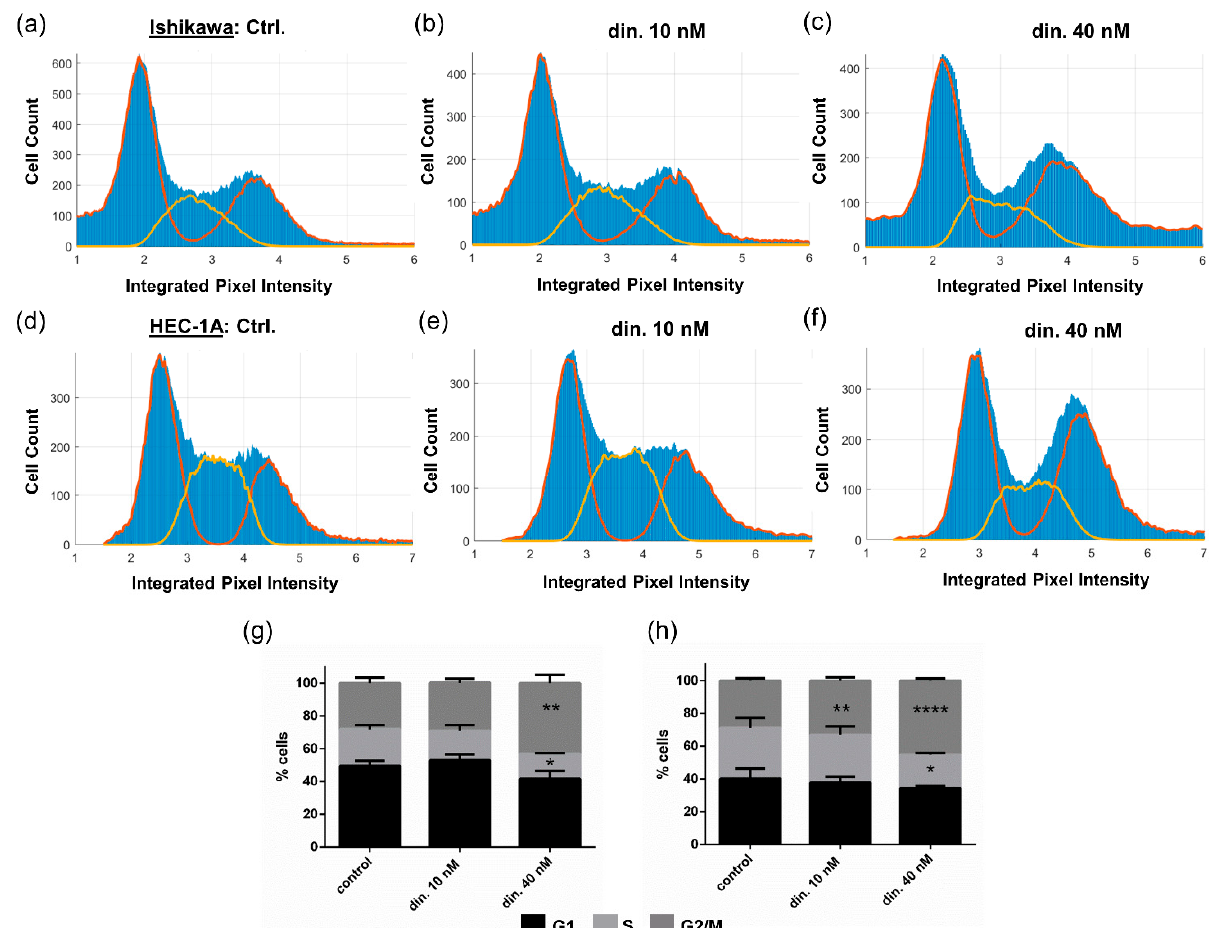
Figure 4. Dinaciclib inhibits cell cycle progression in Ishikawa and HEC-1A cell lines. Cells were treated with either DMSO, or 10 or 40 nM dinaciclib for 24 h, and the nuclei were stained. Nuclear segmentation and DNA content quantification per cell was performed using Cell Profiler. Histograms show ( a ) Ishikawa + control ( b ) Ishikawa + 10 nM dinaciclib, and ( c ) Ishikawa + 40 nM dinaciclib samples, and ( d ) HEC-1A + control, ( e ) HEC-1A + 10 nM dinaciclib and ( f ) HEC-1A + 40 nM dinaciclib samples. The Watson Pragmatic test was used to define G1 and G2/M peaks (red lines on the histograms) and S-phase peaks (yellow lines). The relative percentages of cells in each cell cycle phase (peak integrals) are shown for ( g ) Ishikawa and ( h ) HEC-1A cells. Statistical significance was calculated by ANOVA followed by Dunnett’s test. * p value < 0.05, ** p value < 0.01.